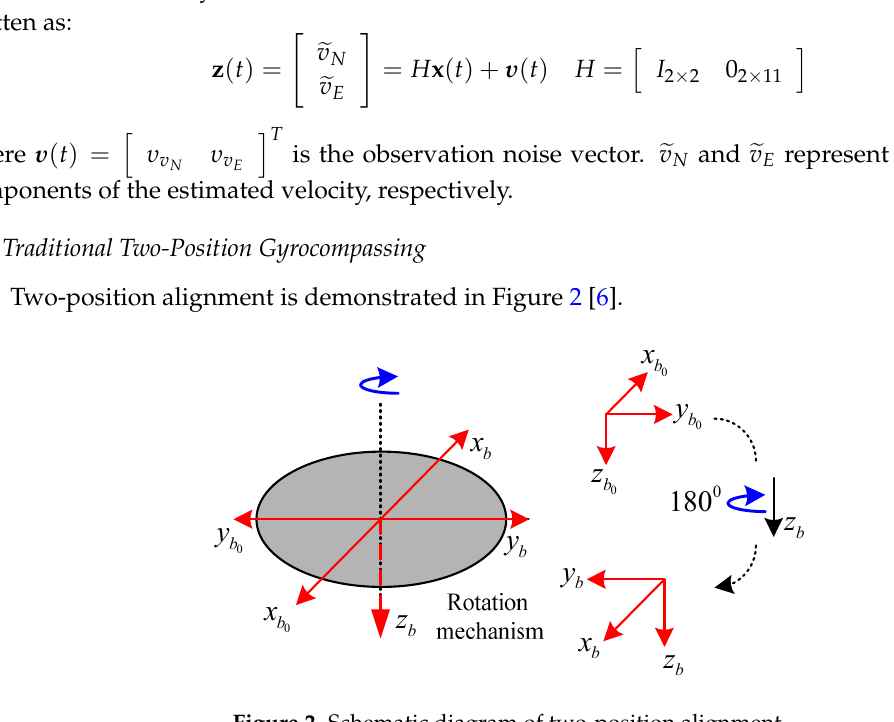
Figure 2. Schematic diagram of two-position alignment.